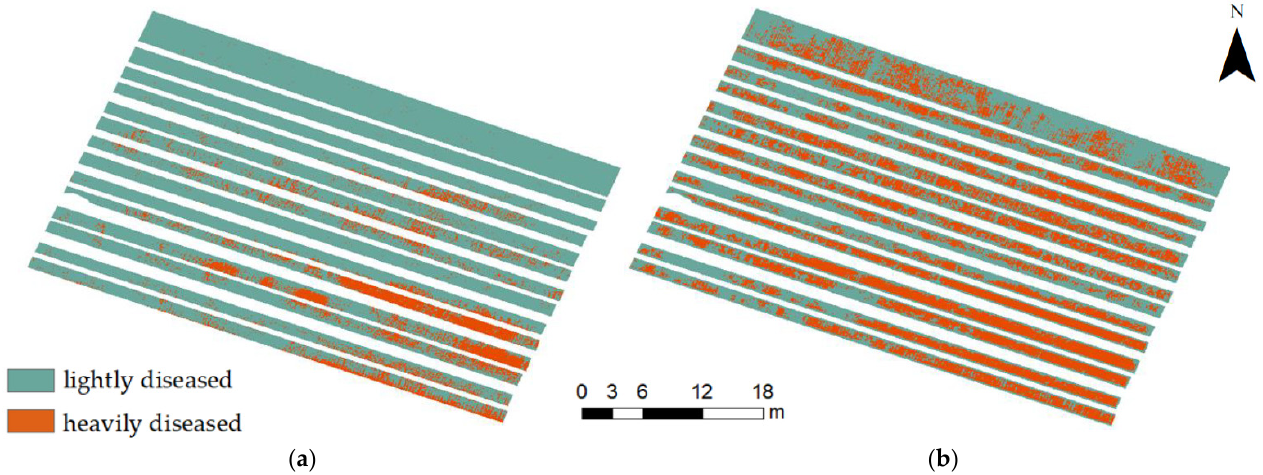
Figure 7. Severely diseased area detection performed by using selected spectral features and the texture features in the optimal window size. ( a ) The results on May 3, when the optimal window size was 5 × 5 pixels; ( b ) the results on May 8, when the optimal window size was 17 × 17 pixels.